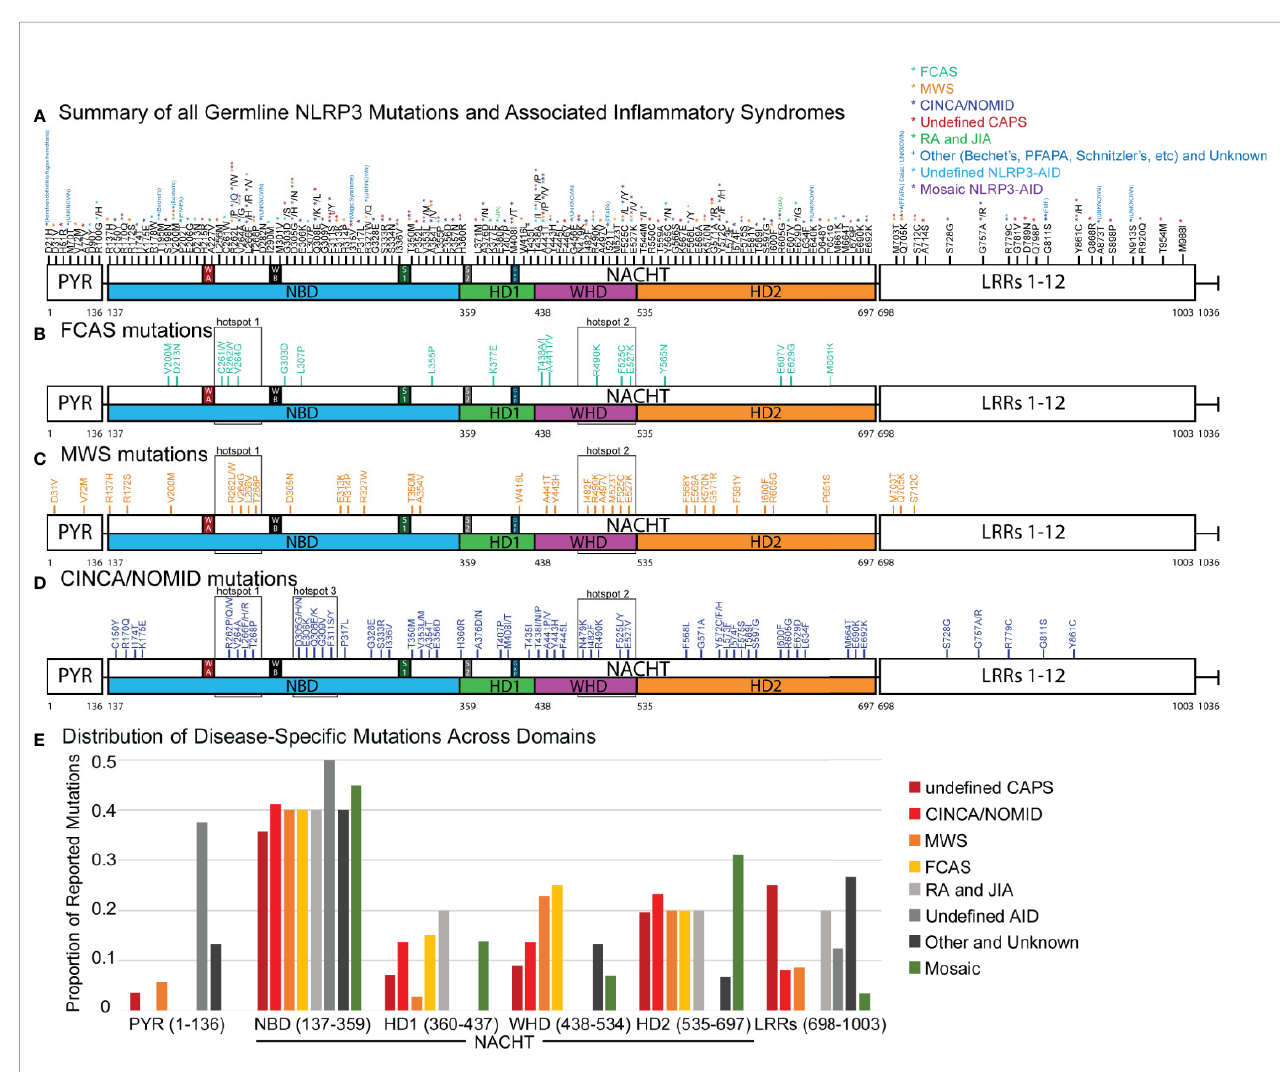
FIGURE 1 | NLRP3 Germline Mutant Protein Maps. (A) Schematic representation of NLRP3 mutation proteomic locations known to cause or be associated with cyropyrin- associated periodic syndromes (CAPS) in fl ammasomopathies [familial cold autoin fl ammatory syndrome (FCAS), Muckle-Wells Syndrome (MWS), and chronic infantile neurologic cutaneous and articular syndrome, also known as neonatal-onset multisystem in fl ammatory disease (CINCA/NOMID)], and other NLRP3- AID. Annotated at each mutated position is the speci fi c amino acid substitution with notation for the diseases associated with the respective substitution corresponding with the color-coded legend in the top-right corner of the panel. Representative proteomic locations of NLRP3 mutations reported in (B) FCAS, (C) MWS, and (D) CINCA/NOMID. (E) The proportion of reported mutations for NLRP3- AID and other NLRP3-mutant conditions color-coded in the legend below the graph. NAIP CIITA HET-E TEP1 (NACHT) domain inset annotations: WA, Walker A motif; WB, Walker B motif; S1, Sensor 1 motif; S2, Sensor 2 motif; GxP, GxP